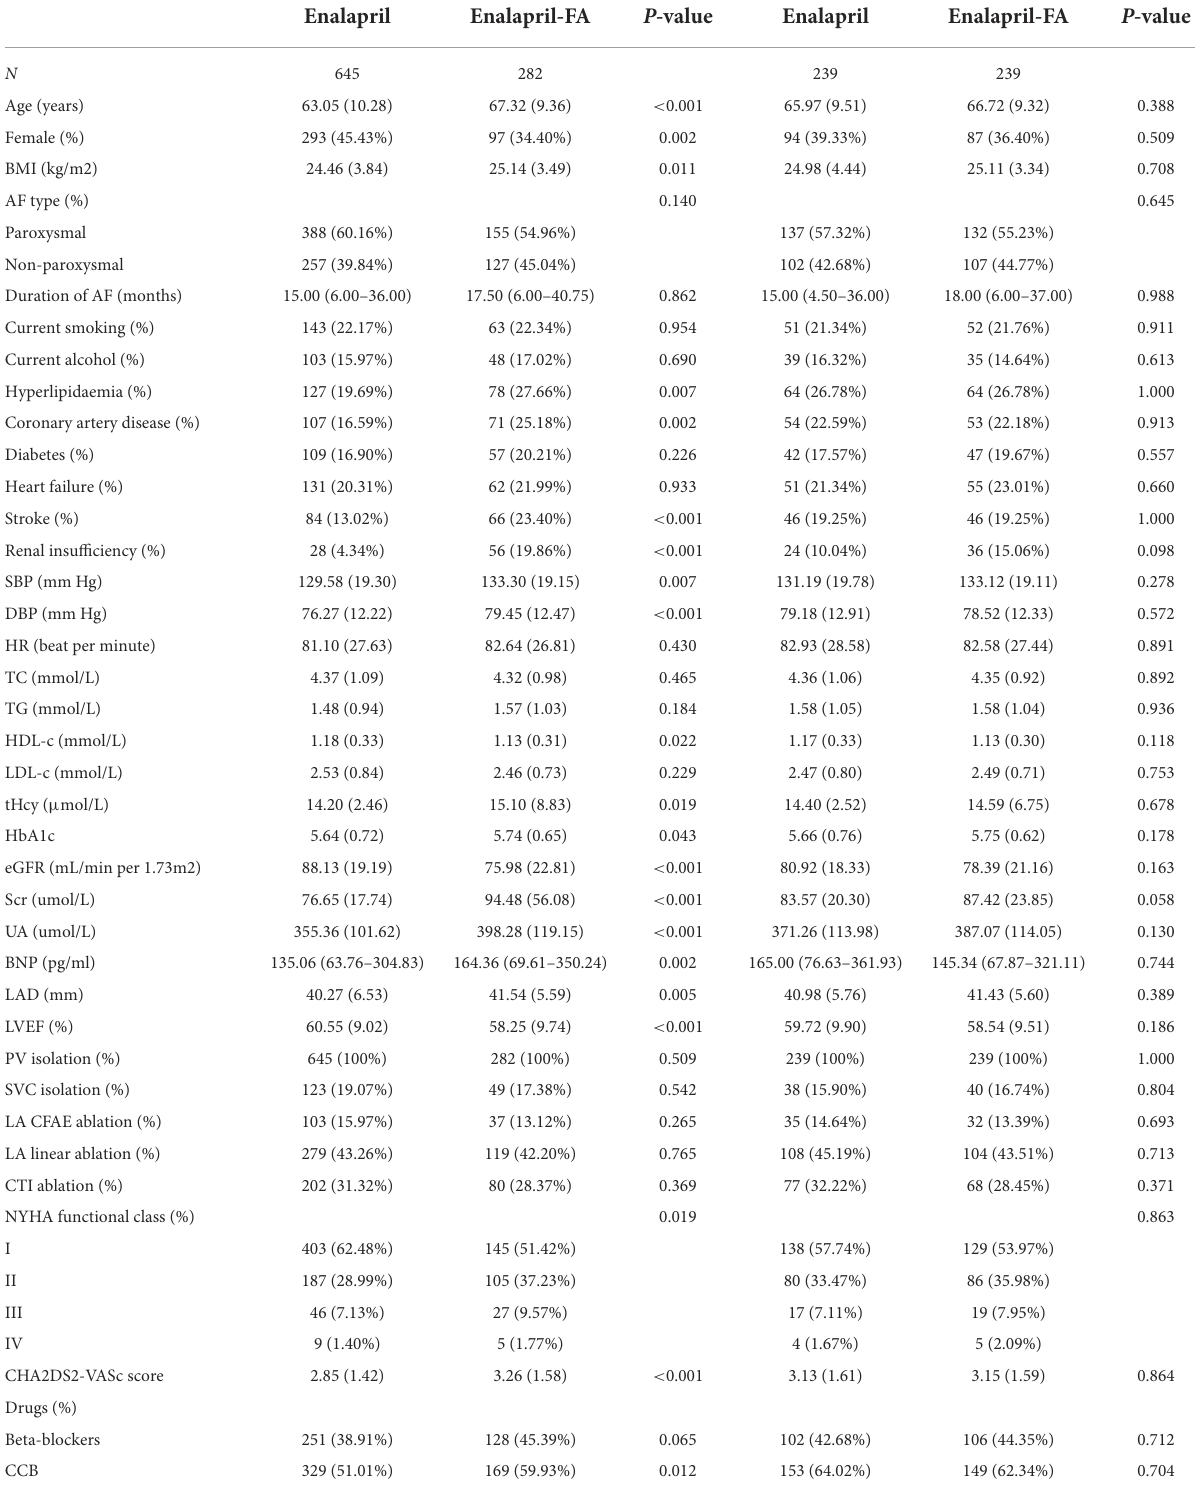
TABLE 1 Baseline characteristics of the study